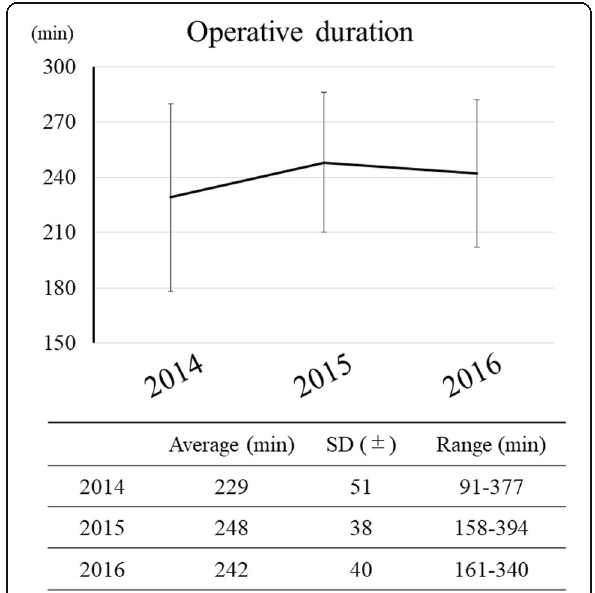
Fig. 2 Annual change in operation duration